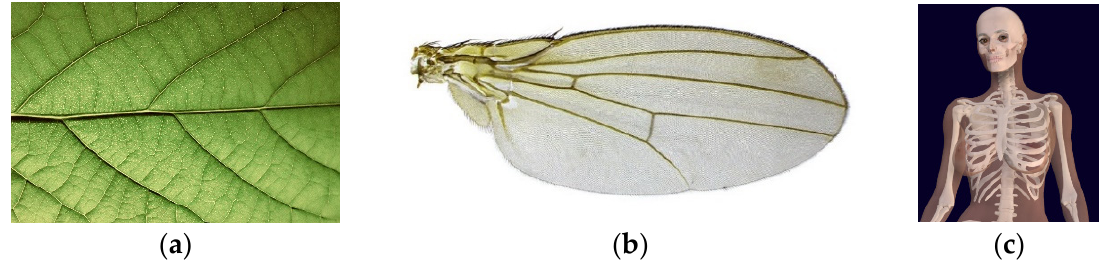
Figure 1. ( a ) Rib–skin structures in a plant leaf (Photo by Daniel Hodgkins on Unsplash (https://unsplash.com/photos/I7sNoicir_I, accessed on 7 September 2021)), ( b ) fly wing (Photo by Martin Hauser Phycus (https://commons.wikimedia.org/